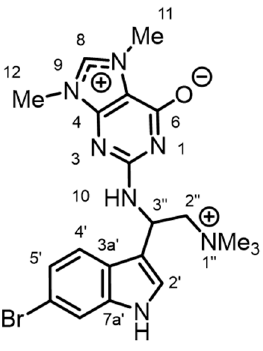
Figure 1. Structure of geobarre tt in D ( 1 ).